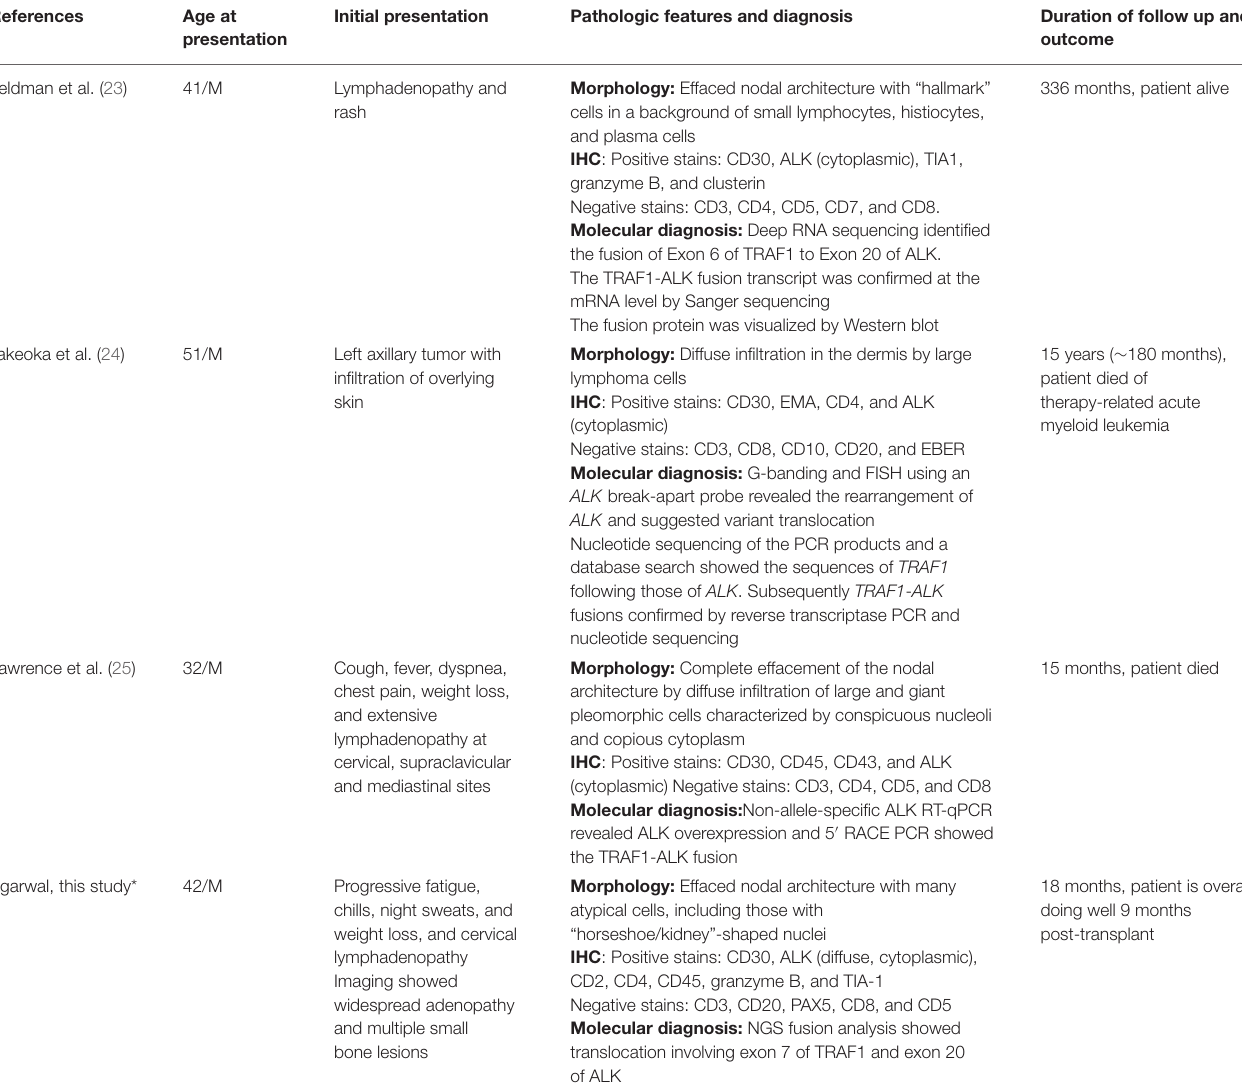
TABLE 1 | Clinical summary and pathology of previously published and current case with ALK-TRAF